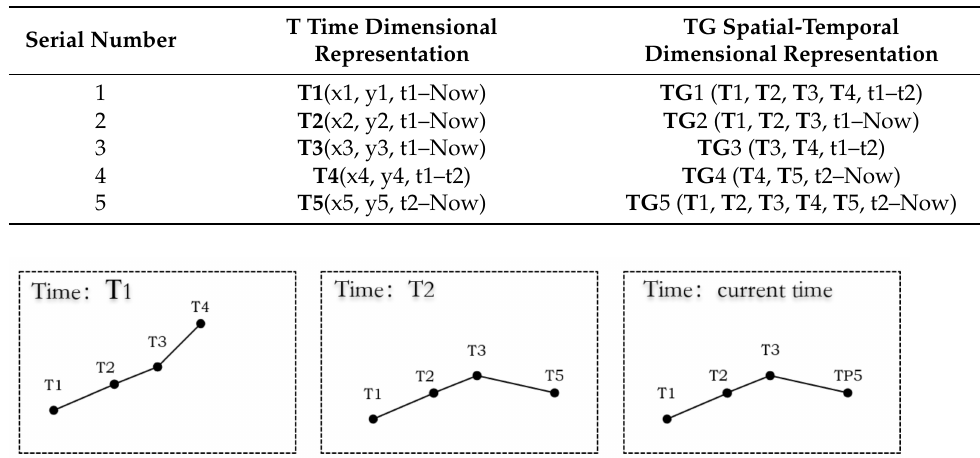
Table 2. Dynamic expression of the geological structure evolution process.